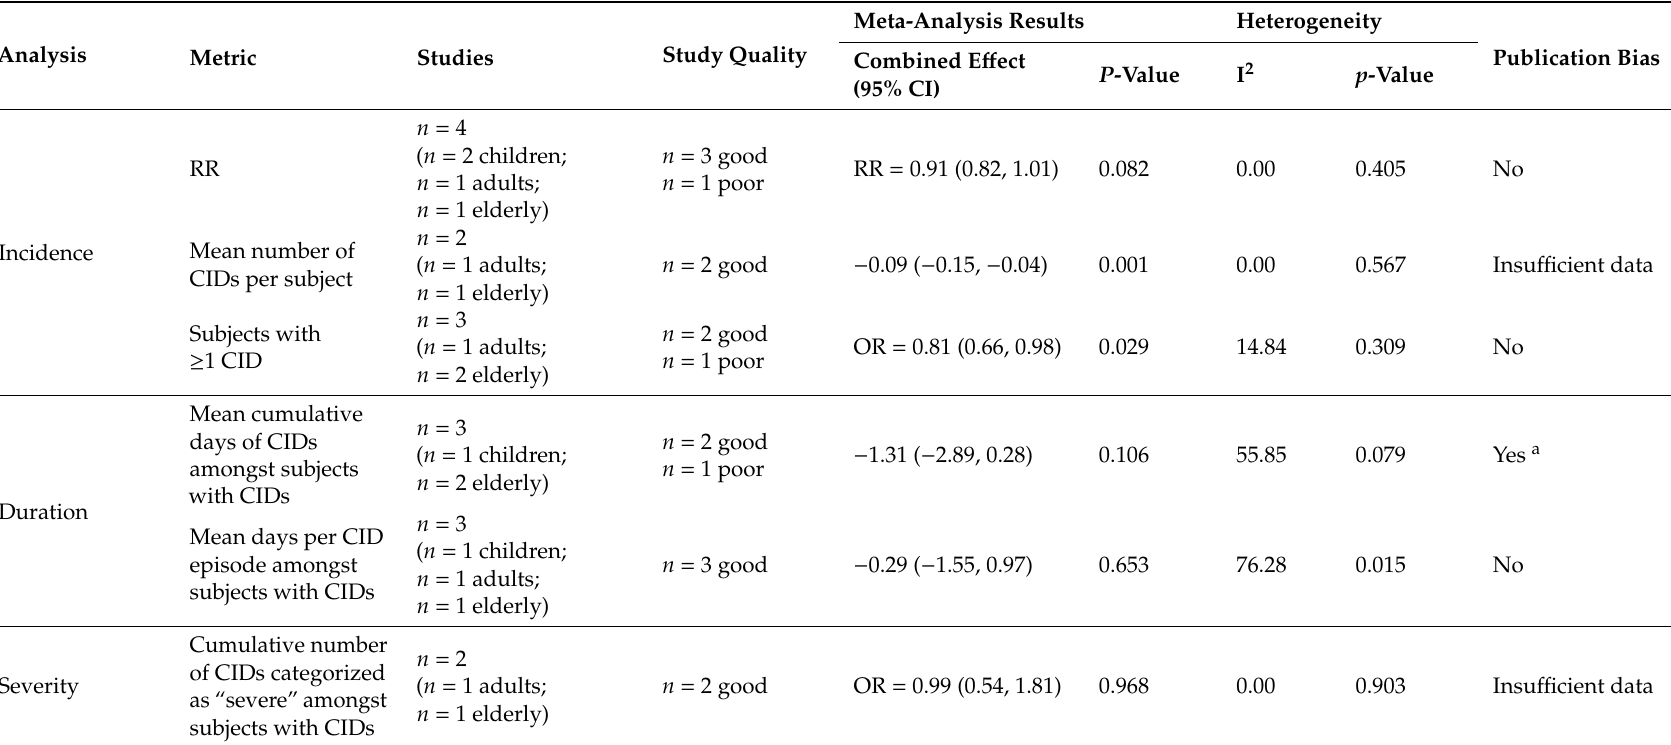
Table 5. Combined e ff ects of a fermented dairy drink containing Lacticaseibacillus paracasei subsp. paracasei CNCM I-1518 and the standard yogurt cultures on common infectious diseases